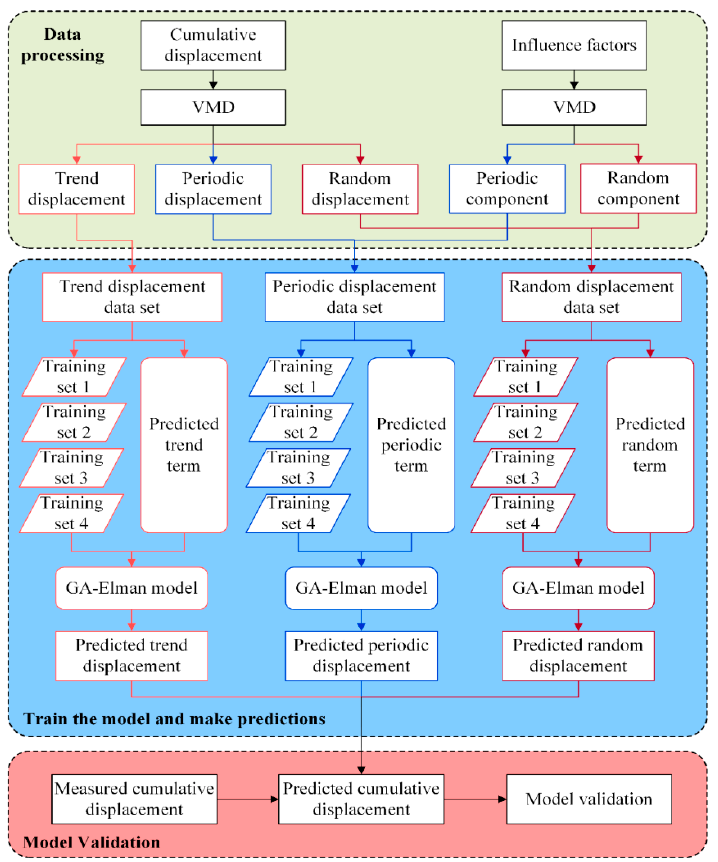
Figure 1. Flowchart of displacement prediction.